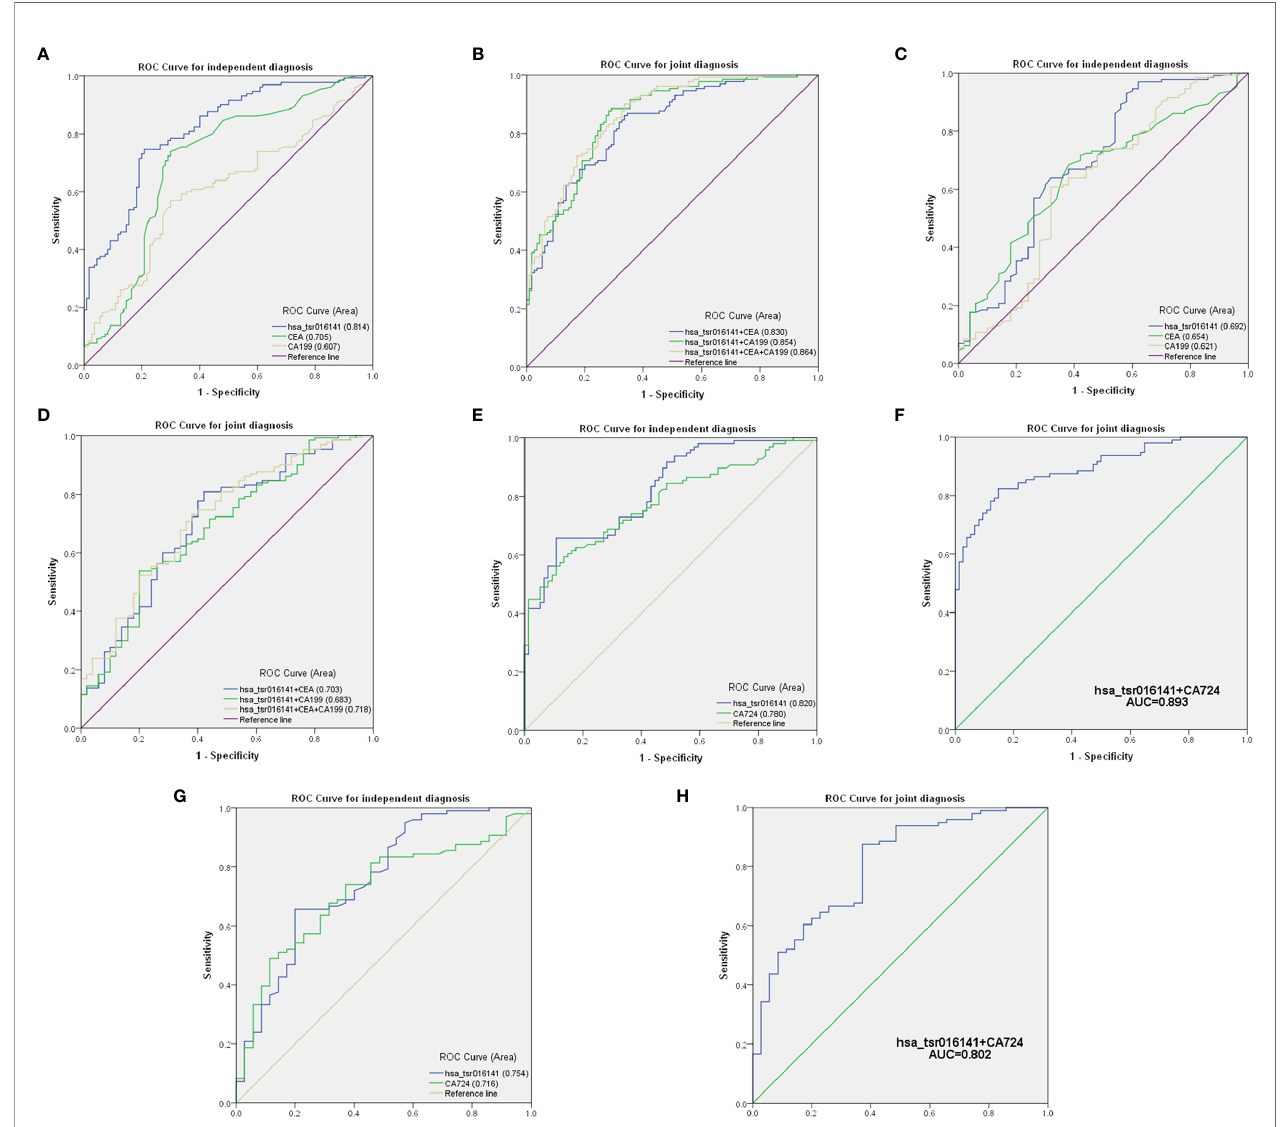
FIGURE 5 | Comparison and combination of serum hsa_tsr016141 and other tumor markers in the diagnosis of GC. (A) ROC curve analysis of hsa_tsr016141, CEA, and CA199 in independent diagnosis of GC patients and healthy donors. (B) ROC curve analysis of hsa_tsr016141, CEA, and CA199 in joint diagnosis of GC patients and healthy donors. (C) ROC curve analysis of hsa_tsr016141, CEA, and CA199 in independent diagnosis of GC patients and gastritis patients. (D) ROC curve analysis of hsa_tsr016141, CEA, and CA199 in joint diagnosis of GC patients and gastritis patients. (E) ROC curve analysis of hsa_tsr016141 and CA724 in independent diagnosis of GC patients and healthy donors. (F) ROC curve analysis of hsa_tsr016141 and CA724 in joint diagnosis of GC patients and healthy donors. (G) ROC curve analysis of hsa_tsr016141 and CA724 in independent diagnosis of GC patients and gastritis patients. (H) ROC curve analysis of hsa_tsr016141 and CA724 in joint diagnosis of GC patients and gastritis patients.